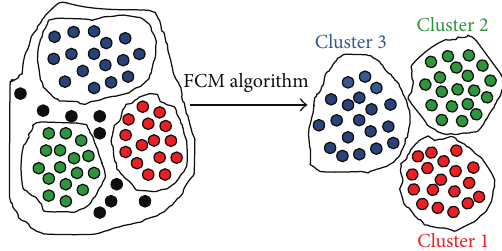
Figure 5: Step 2 of F-ASClass algorithm.